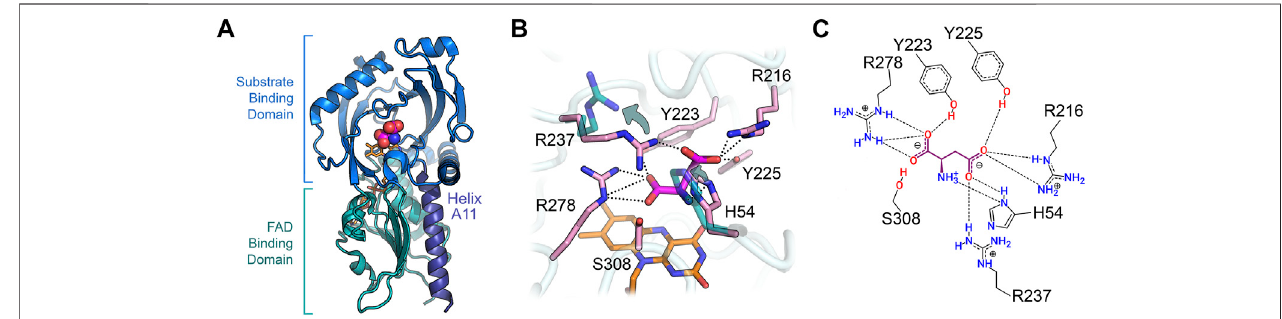
FIGURE4| Three-dimensionalstructureofhumanDASPO(PDBentry6rkf). (A) OverallfoldofthehDASPOmonomer.TheFADbindingdomainisshownintealand the substrate binding domain is shown in blue. The substrate D-Asp, docked at the active site (Molla et al., 2020), is shown with a sphere representation. The FAD cofactor is in orange and α -helix A11 is depicted in violet. (B) Close up of the active site. The side chains of residues Arg237 and His54 in the alternative open conformation are shown in teal (see arrows); non-covalent interactions between D-Asp and the active site residues are shown as dotted lines. (C) Scheme of the interaction of D-Asp at the active site: H-bonds are shown as dotted